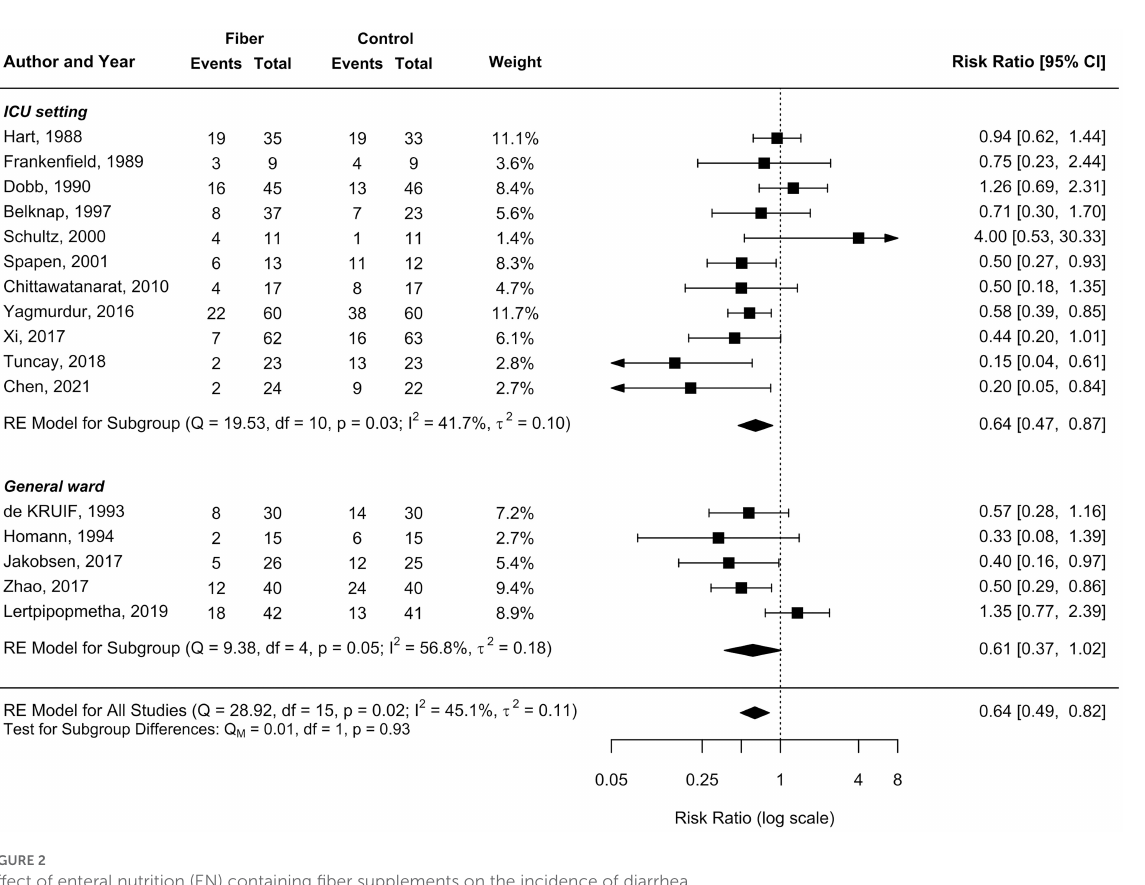
FIGURE2 Effect of enteral nutrition (EN) containing fiber supplements on the incidence of diarrhea.